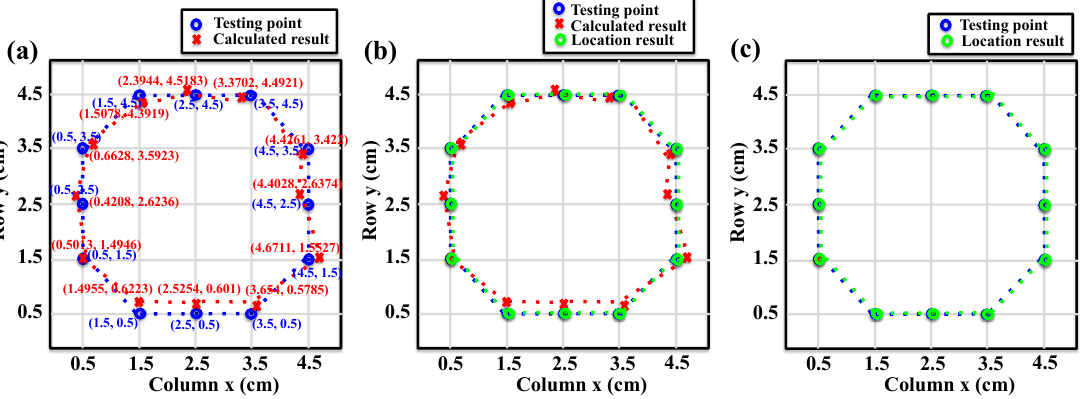
Figure 7. The actual position of the twelve testing points (blue), the calculated results (red) and the final location results (green) of the circle-pointing experiment. ( a ) Comparison of the actual position of the testing points with the calculated results; ( b ) Comparison of the actual position of the testing points with the calculated results and the final location results; ( c ) Comparison of the actual position of the testing points and the final location results, indicating perfect reconstruction of the testing positions.